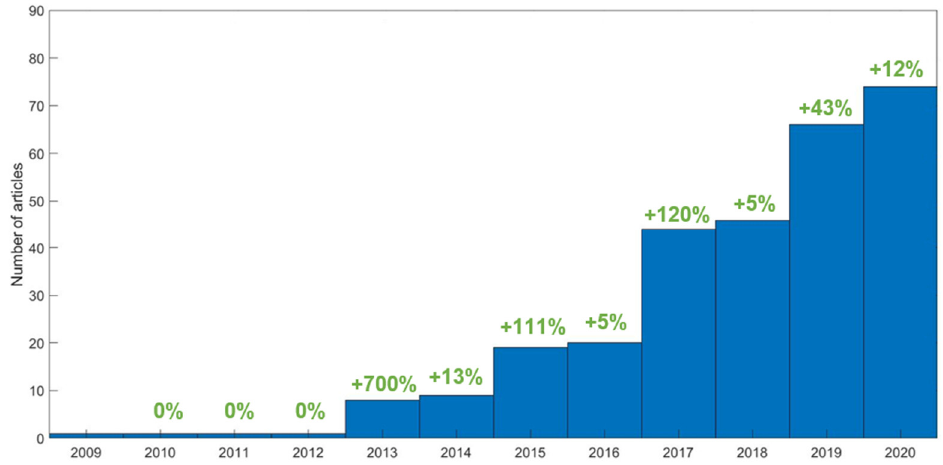
Figure 3. The number of publications per year. In green, the interannual increase.